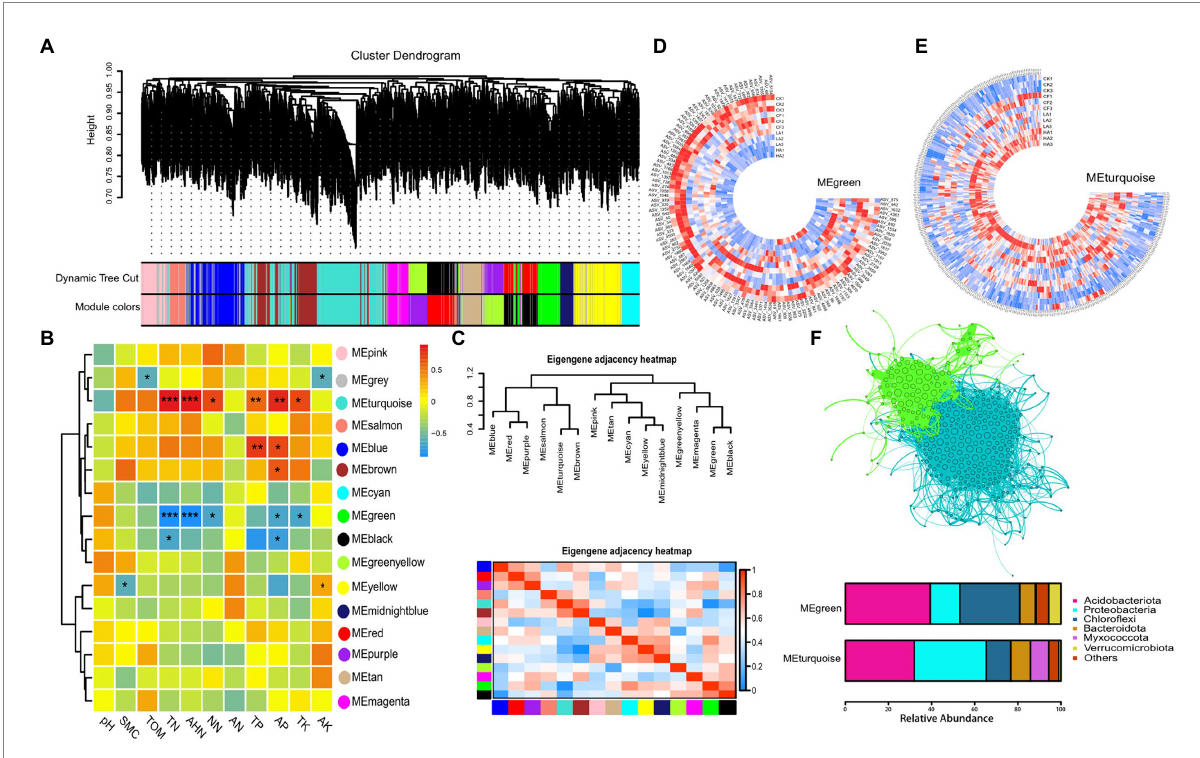
FIGURE 3 Ecological clusters generated by WGCNA. (A) WGCNA module plot. Dynamic tree cut represents initial clusters. Module colors represent final clusters. Each branch in the hierarchical tree or each vertical line in color bars represents one gene. Genes not attributed to any module are colored gray. (B) Pearson correlation heatmap between ecological clusters and physicochemical factors. (C) Pearson correlation heatmap between different ecological clusters. (D) Distribution of MEgreen in each treatment. Each color represents one module. (E) Distribution of MEturquoise in each treatment. (F) Network and species composition of MEgreen and